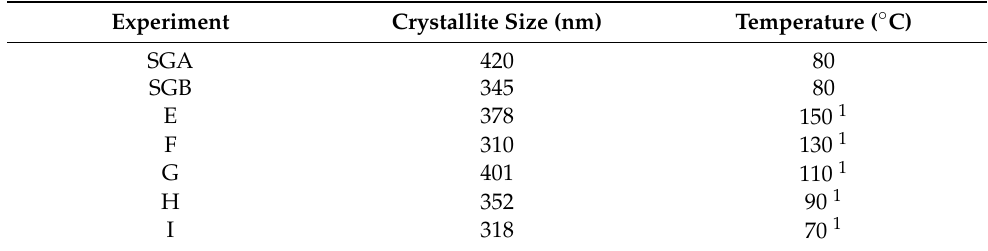
Table 2. Calculated crystallite size of double perovskite from SGA and SGB reference experiments, and those from microwave assisted technique E, F, H, and I. The average values were obtained by the SSP method. The complete statistical data from linear fit is presented in Supplementary Materials Table S1.